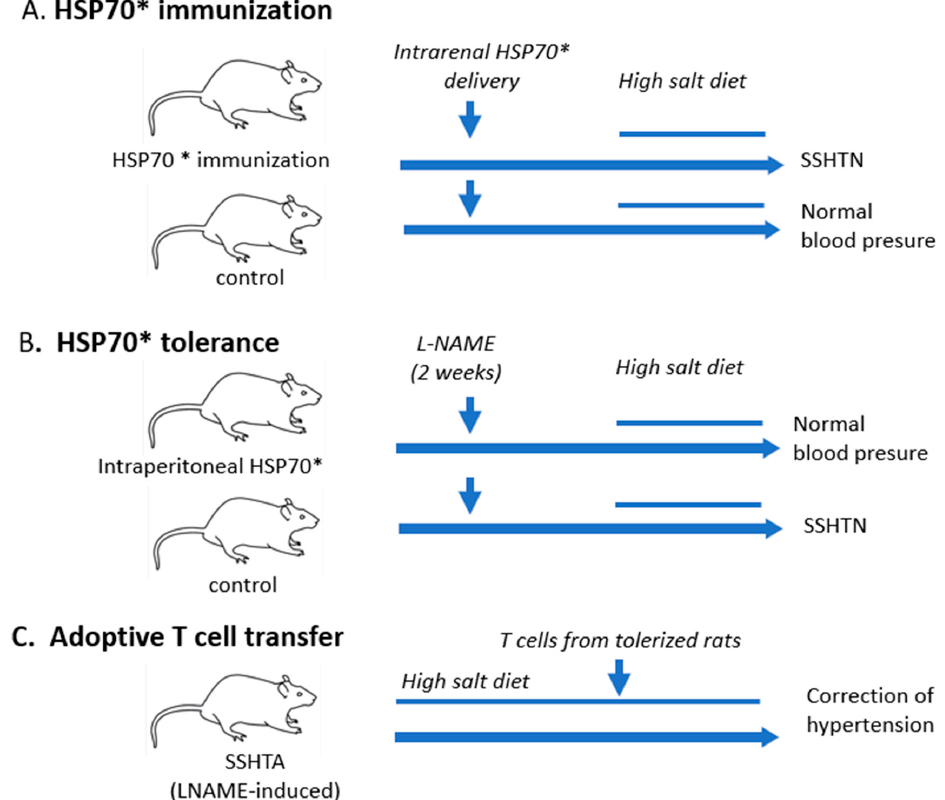
Figure 3. HSP70 immune reactivity and hypertension. ( A ) Immunization with a specific amino acid